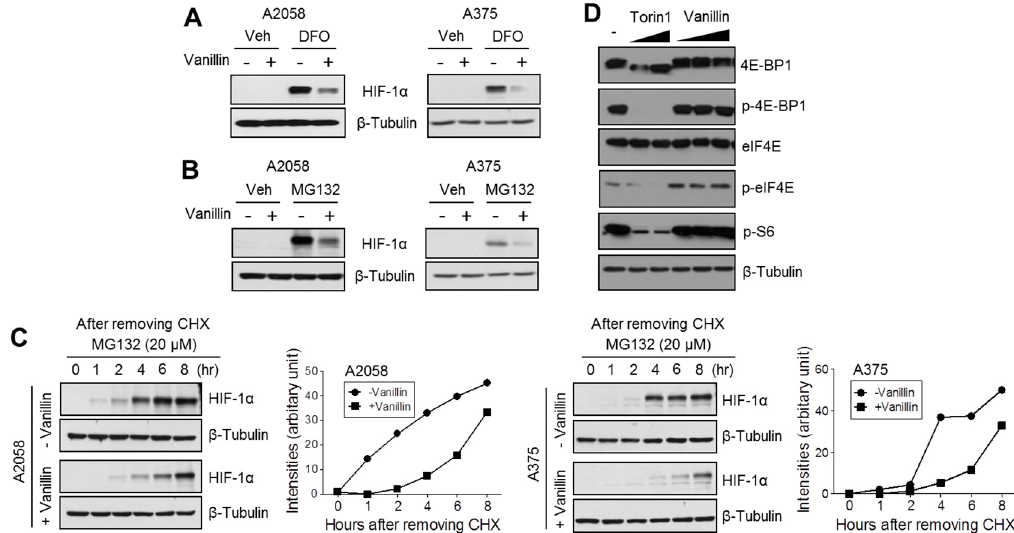
Figure 3. Vanillin attenuates HIF-1 α protein synthesis. ( A ) Vanillin suppresses HIF-1 α increased by treatment with the iron chelator, deferoxamine (DFO), under normoxic condition. A2058 and A375 cells were pre-incubated with 2.5 mM of vanillin for 1 h, and then further incubated in the absence or presence of 50 µ M of DFO for 6 h; ( B ) Vanillin suppresses HIF-1 α increased by proteasome inhibitor (MG132) treatment. Cells were pre-incubated with 2.5 mM of vanillin for 1 h, and then further incubated in the absence or presence of 20 µ M of MG132 for 6 h; ( C ) Vanillin attenuates de novo HIF-1 α protein synthesis. Cells were pre-incubated with 100 µ M cycloheximide (CHX) for 12 h and then washed with phosphate-buffered saline (PBS). Cells were incubated with fresh culture medium containing 20 µ M of MG132 and 2.5 mM of vanillin (or dimethyl sulfoxide (DMSO)) for indicated time. HIF-1 α protein levels were detected by immunoblotting, and then protein levels were quantified using Image J software; ( D ) Vanillin does not regulate the signal transduction pathway related to 5 ′ -cap-dependent translation.